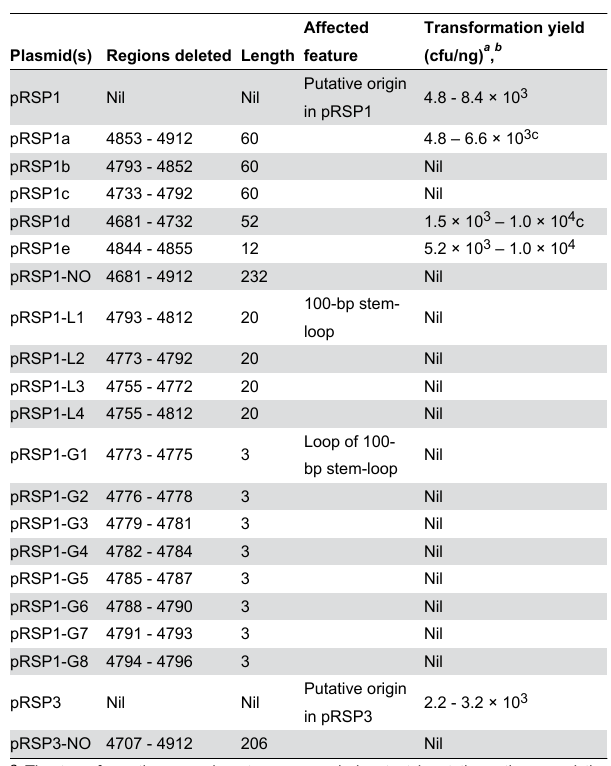
Table 3. Effect of deletion within putative origin of pRSP1 and pRSP3 on transformation